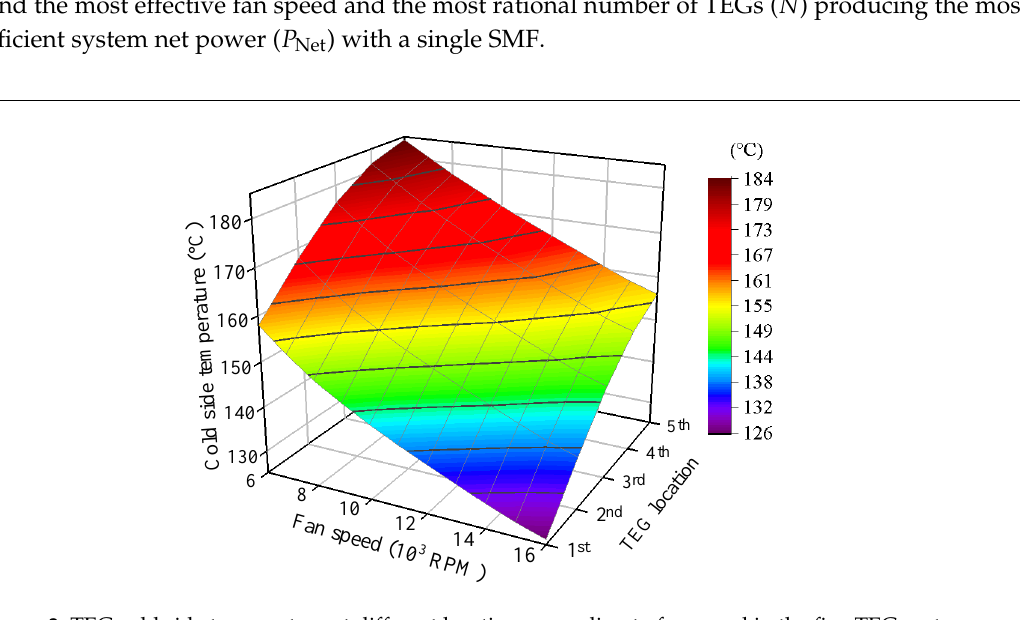
Figure 3. TEG cold side temperature at different locations according to fan speed in the five TEG